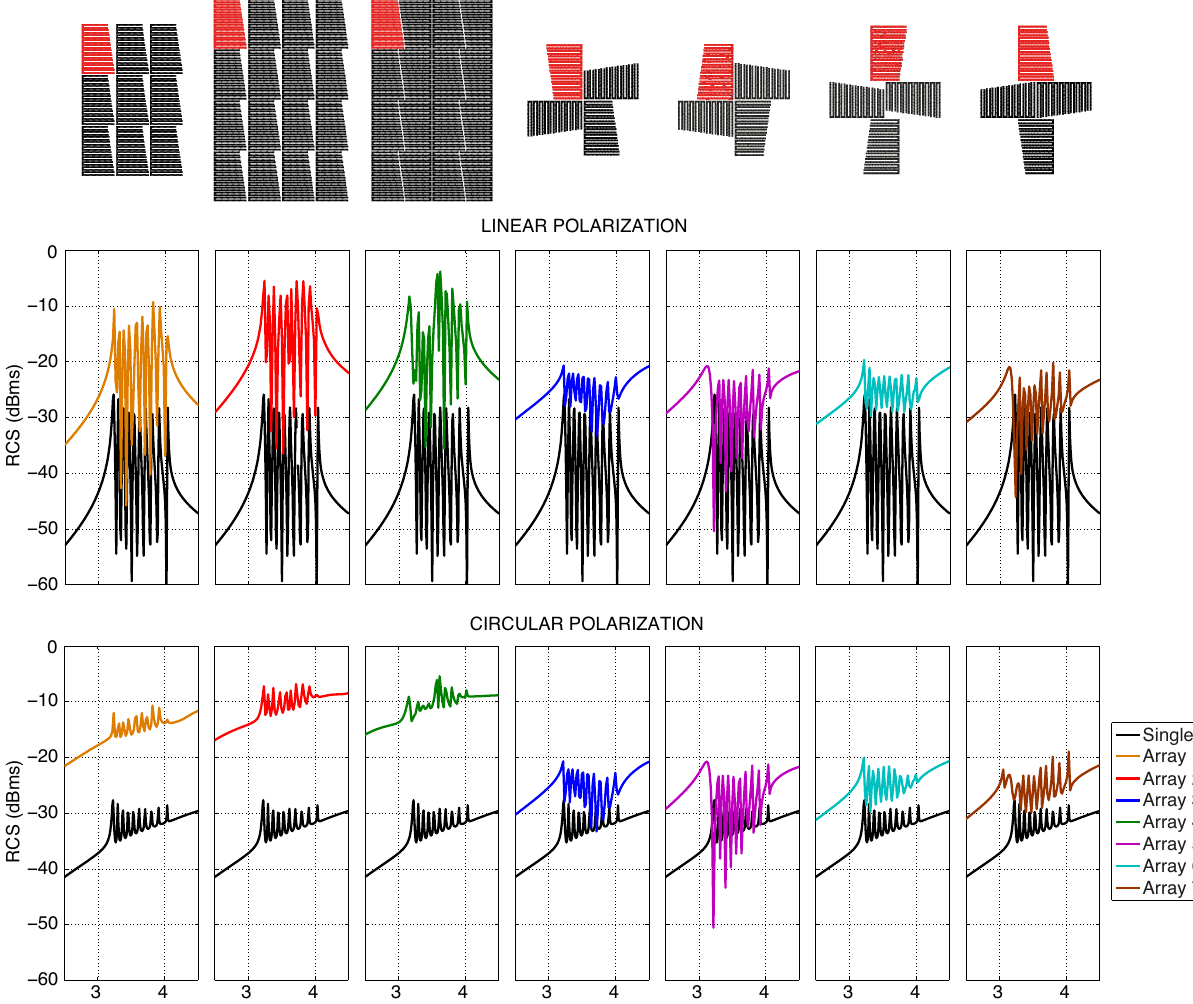
Figure 11: Different arrays involving alternative arrangements of multiple tags. RCS of each array is shown for both linear and circular polarizations, in comparison to those for a single